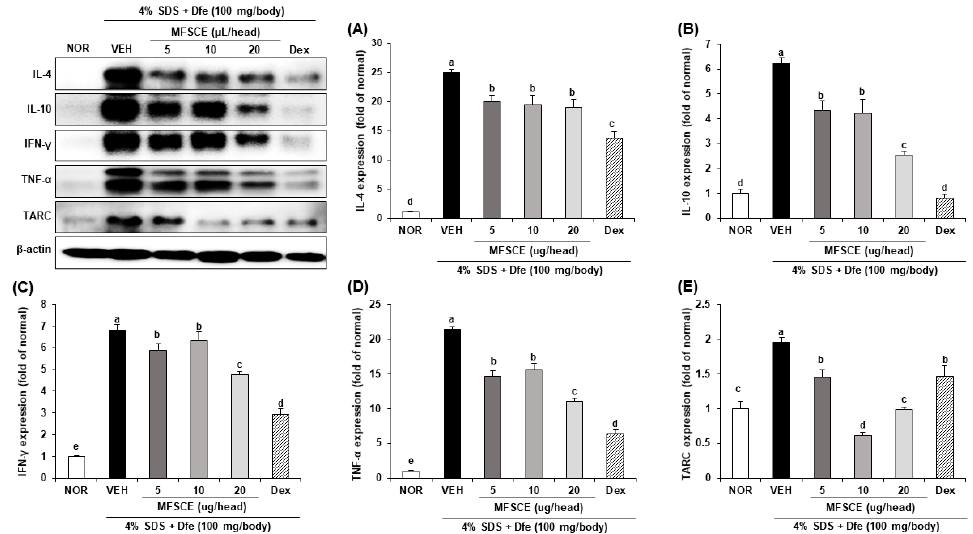
Figure 7. E ff ect of MFSCE on IL-4 ( A ), IL-10 ( B ), IFN- γ ( C ), TNF- α ( D ), and TARC ( E ) expression in AD-like dorsal skin of HDM-sensitized NC/Nga mice. Values are mean ± SD. a–e Means with di ff erent le tt ers are signi fi cantly di ff erent ( p < 0.05) as determined by Duncan’s multiple range test. The mice were grouped and treated as described in Figure 2.